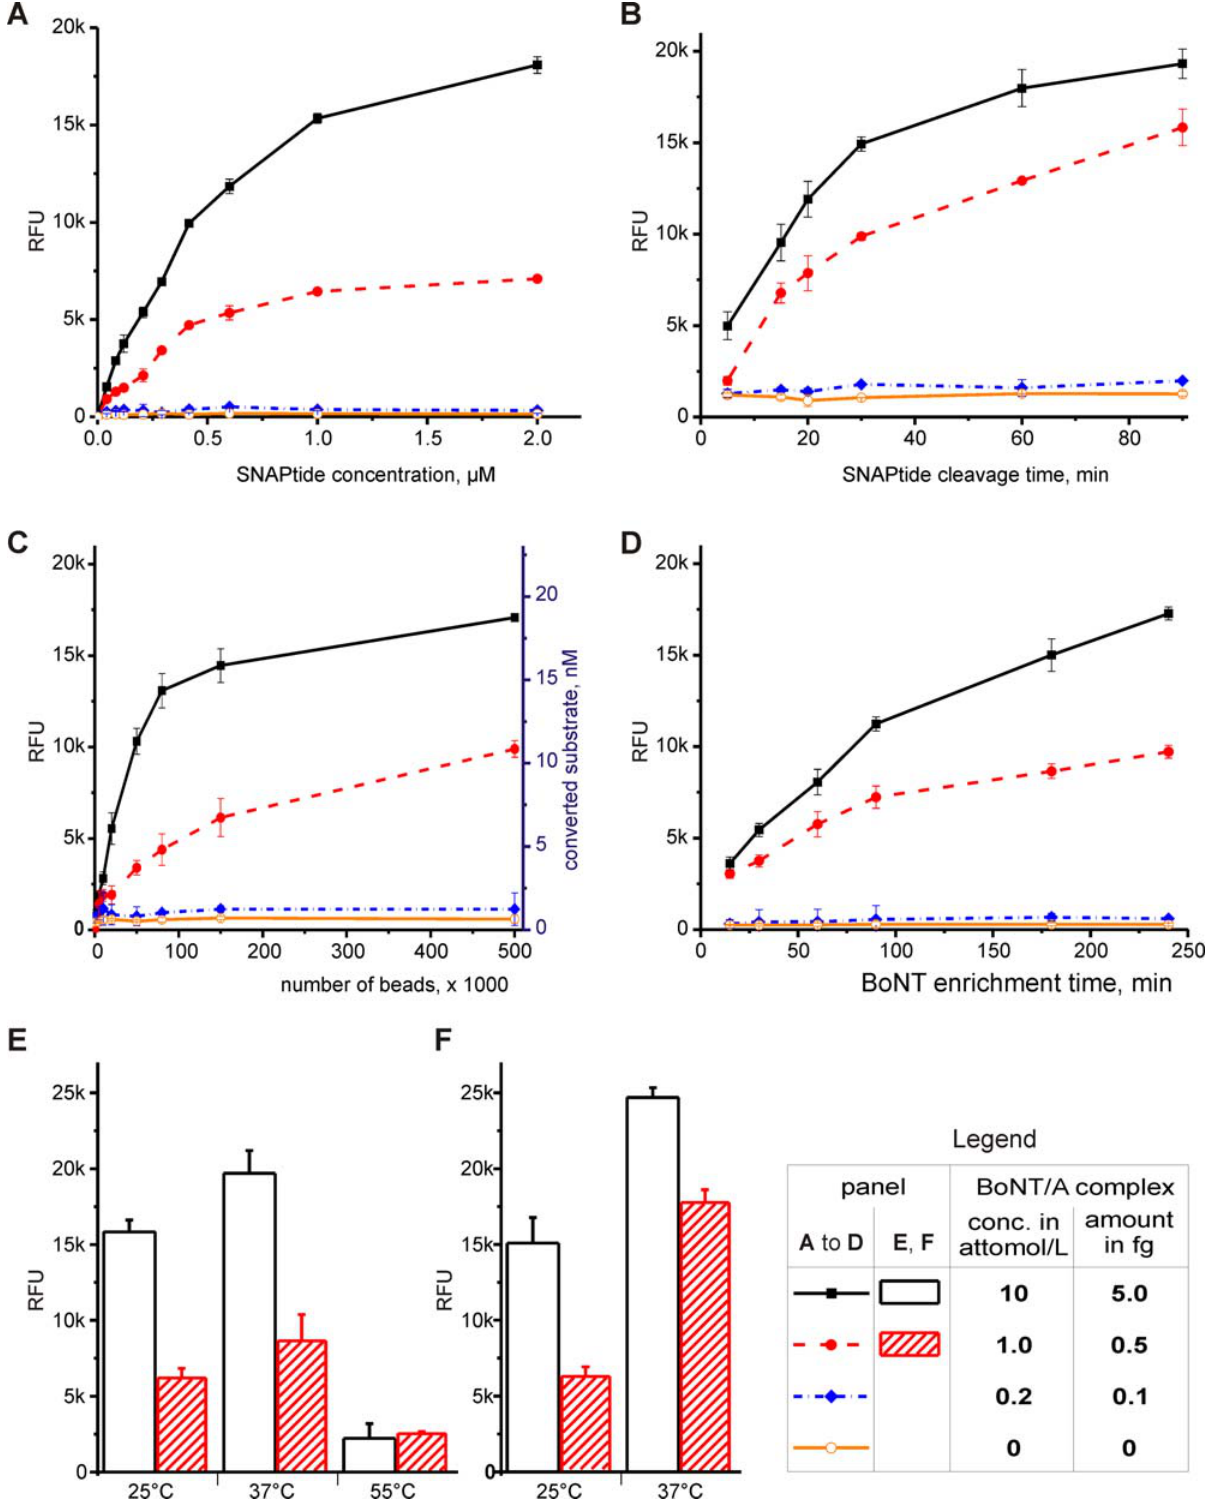
Figure 2. Optimization of the BoNT/A ALISSA in 10% fetal bovine serum. Effect of (A) SNAPtide concentration of SNAPtide after a 1 hr reaction time, (B) SNAPtide cleavage time, (C) number of beads, (D) BoNT enrichment time, (E) temperature during BoNT/A enrichment and (F) temperature on cleavage of the SNAPtide. The following parameters were kept constant unless when varied as indicated: BoNT/A binding and cleavage reaction (25 u C); SNAPtide concentration (1 m M); BoNT/A enrichment time and SNAPtide cleavage time (1 hr each); number of beads (120,000).